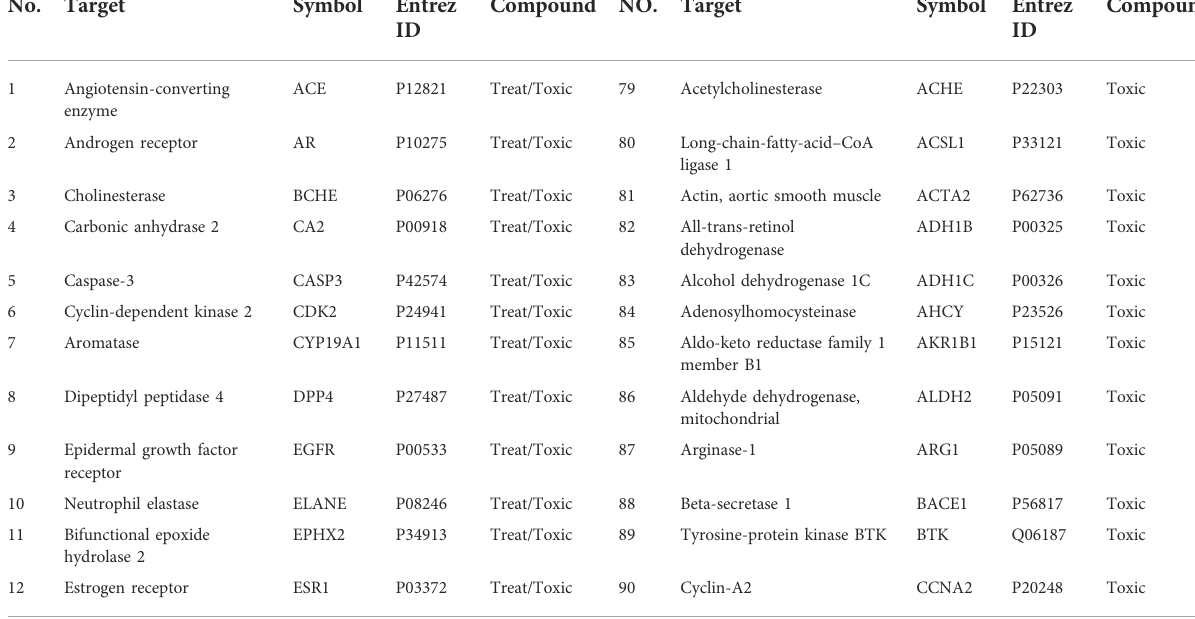
TABLE 2 The detail gene name of potential targets of AO in the treatment of PIH and AO toxic compounds induced